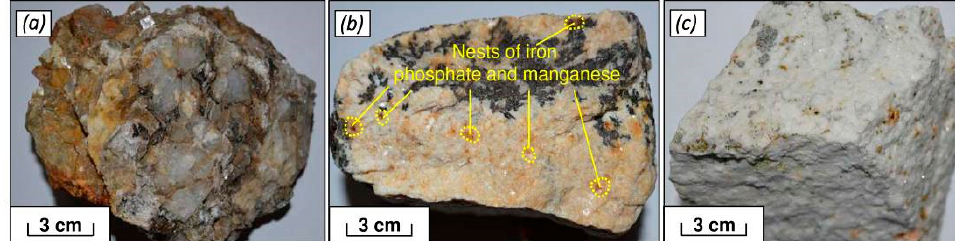
Figure 7. Pegmatites from the Tochka area. ( a ) Coarse-grained weakly albitized quartz–microcline pegmatite; ( b ) albitized pegmatite with nests of iron phosphate and manganese (dark inclusions); ( c ) albite pegmatite with disseminated metallic minerals.